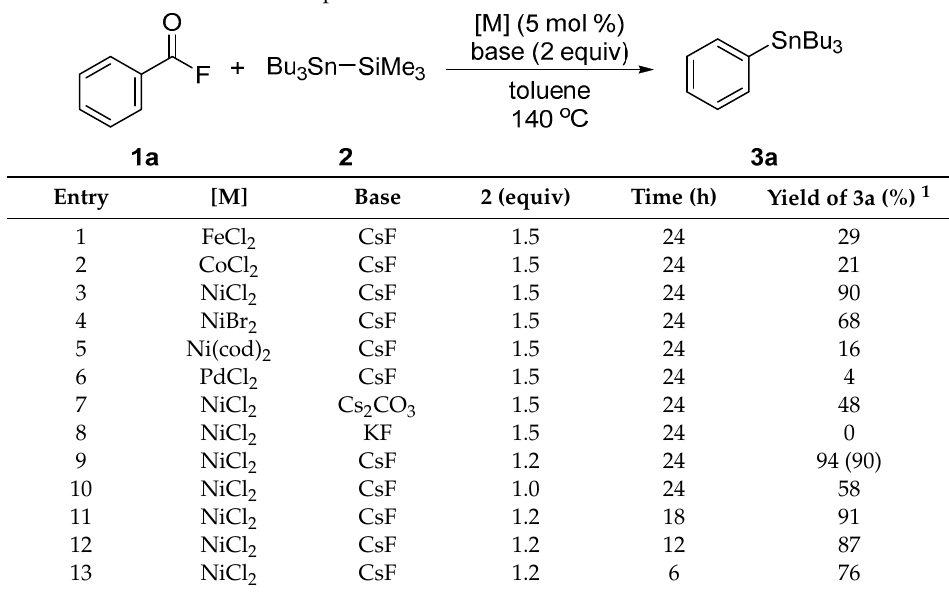
Table 1. Optimization of the reaction conditions.